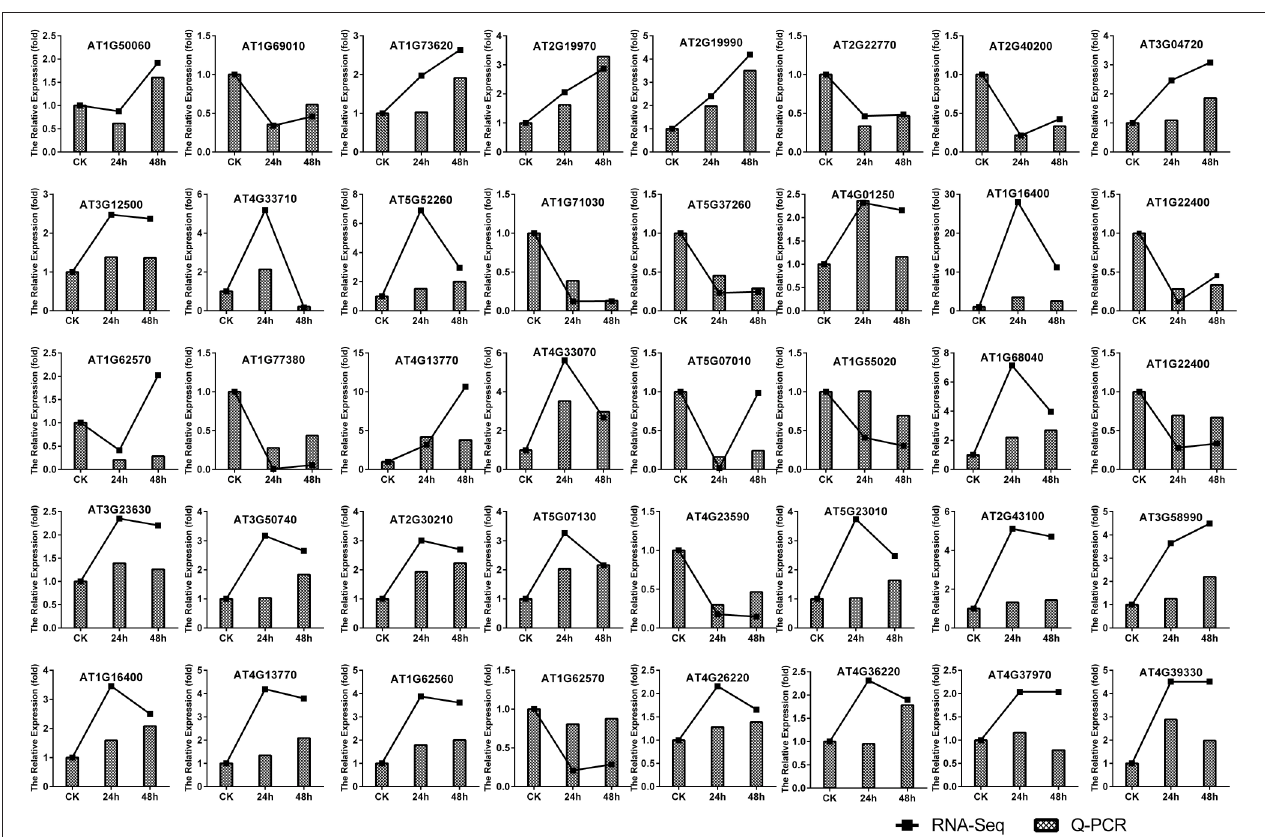
FIGURE 2 | Verification of gene expression patterns in A. thaliana during early infection by P. brassicae by qRT-PCR. Forty DEGs (including 10 PR genes, three MYB transcription factor genes, one WRKY gene, 11 genes from the model of the IAA, SA, JA, and cytokinins signal pathway, 11 genes associated with secondary metabolism, and four cell wall-related genes) were selected to validate the reliability of the RNA-seq results. The expression of A. thaliana actin (AT3G18780) was used to normalize the expression of the genes in each corresponding qRT-PCR sample using actin-specific primers. The relative level of expression of individual genes in the CK was set as